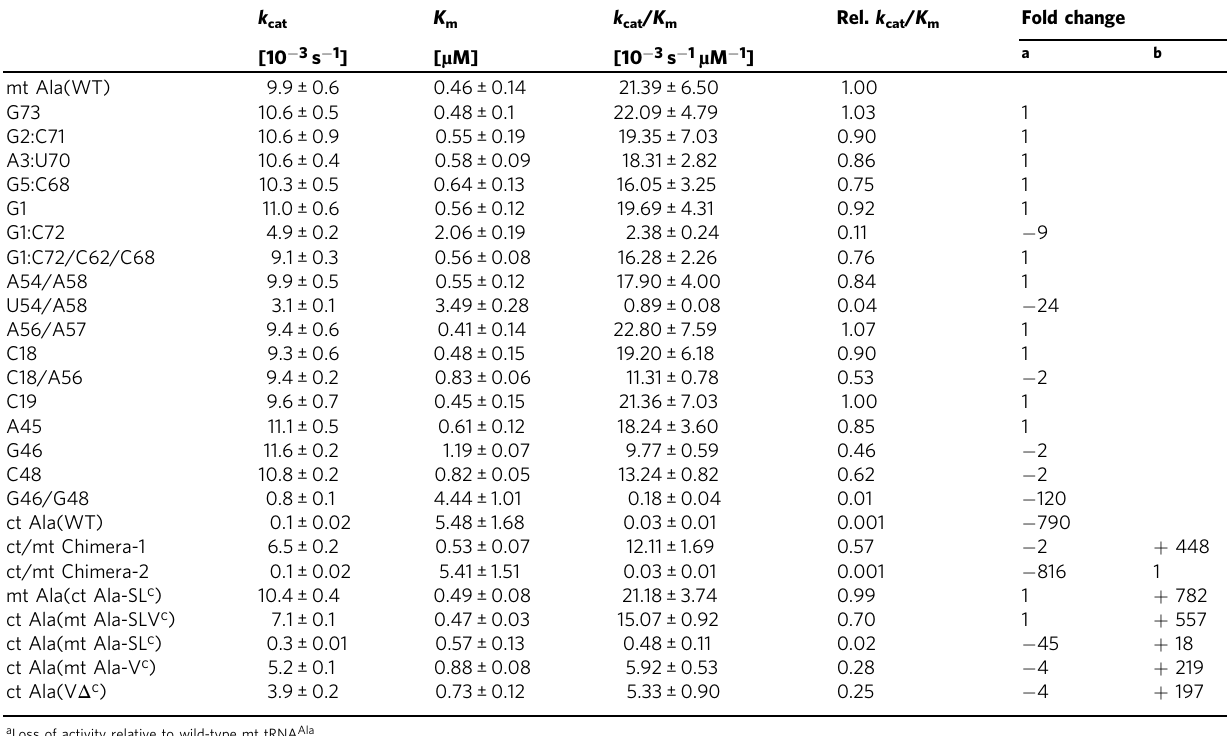
Table 1 Kinetics of aminoacylation of tRNA Ala variants by Hs mt AlaRS (related to Fig.